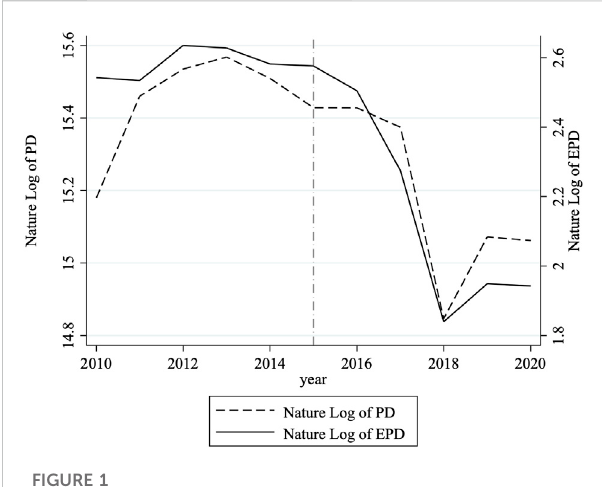
FIGURE 1 Mean nature log of PD and